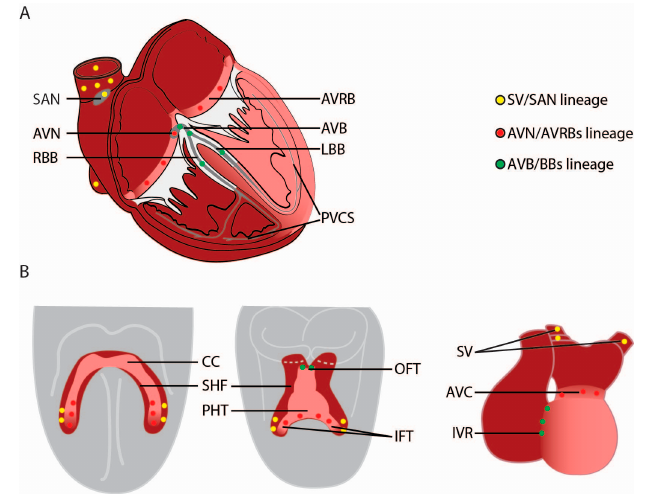
Figure 1. Developmental origin of the cardiac conduction system components. ( A ) The mature cardiac conduction system (CCS, grey) consists of the sinoatrial node (SAN), the atrioventricular node (AVN) and ring bundles (AVRBs), the atrioventricular bundle (AVB), left and right bundle branches (LBB and RBB, respectively) and the peripheral ventricular conduction system (PVCS). The contributions of the first and second heart field (FHF and SHF, respectively) to the adult myocardium are visualized in pink (FHF-derived) and dark red (SHF-derived); ( B ) Cardiogenic mesodermal cells of the FHF differentiate and form the cardiac crescent (CC) at E7.5. The primary heart tube (PHT) forms through fusion of the cardiac crescent (E8) and subsequently forms the myocardium of the left ventricle and part of the atrioventricular canal (AVC). Cardiogenic mesodermal cells of the SHF are continuously added to the arterial and venous pole of the heart tube and form the other myocardial components of the heart. The locations of the progenitor cells of the CCS components are depicted by yellow circles for the SV/SAN, red circles for AVN/AVRBs and green circles for AVB/BBs. Abbreviations: IFT, inflow tract; IVR, interventricular ring, OFT, outflow tract; SV, sinus